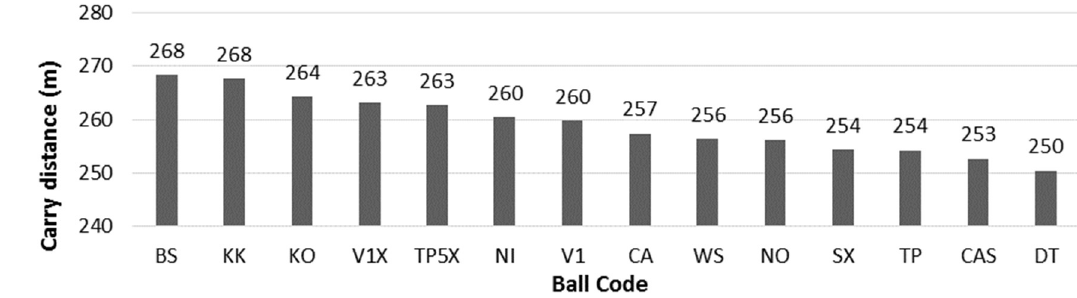
Figure 5. Simulated carry distance for all golf ball models.